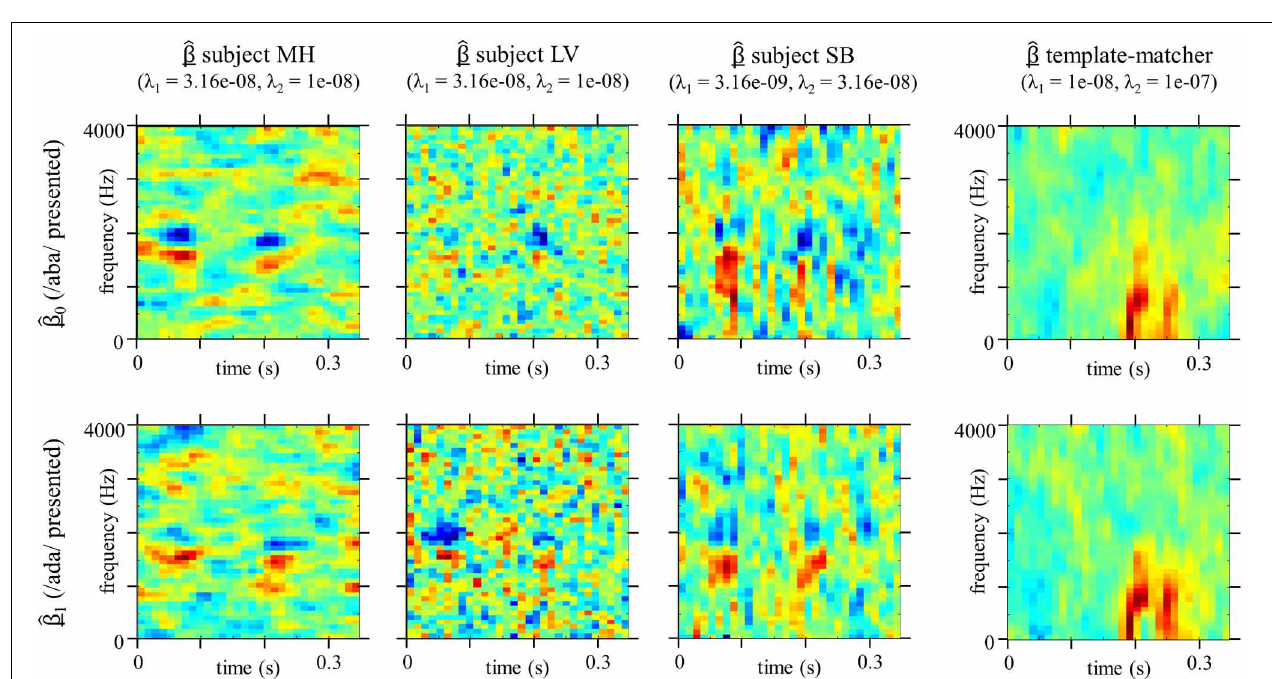
FIGURE 7 | Classification Images (cid:2) β and (cid:2) β 1 estimated on the trials where t 0 (/aba/) or t 1 (/ada/) was presented respectively ( n = 5000 trials for each 0 estimate). Hyperparameters values are the same as for the “overall” Classification Images Figure 4 . Weights are divided by their maximum absolute